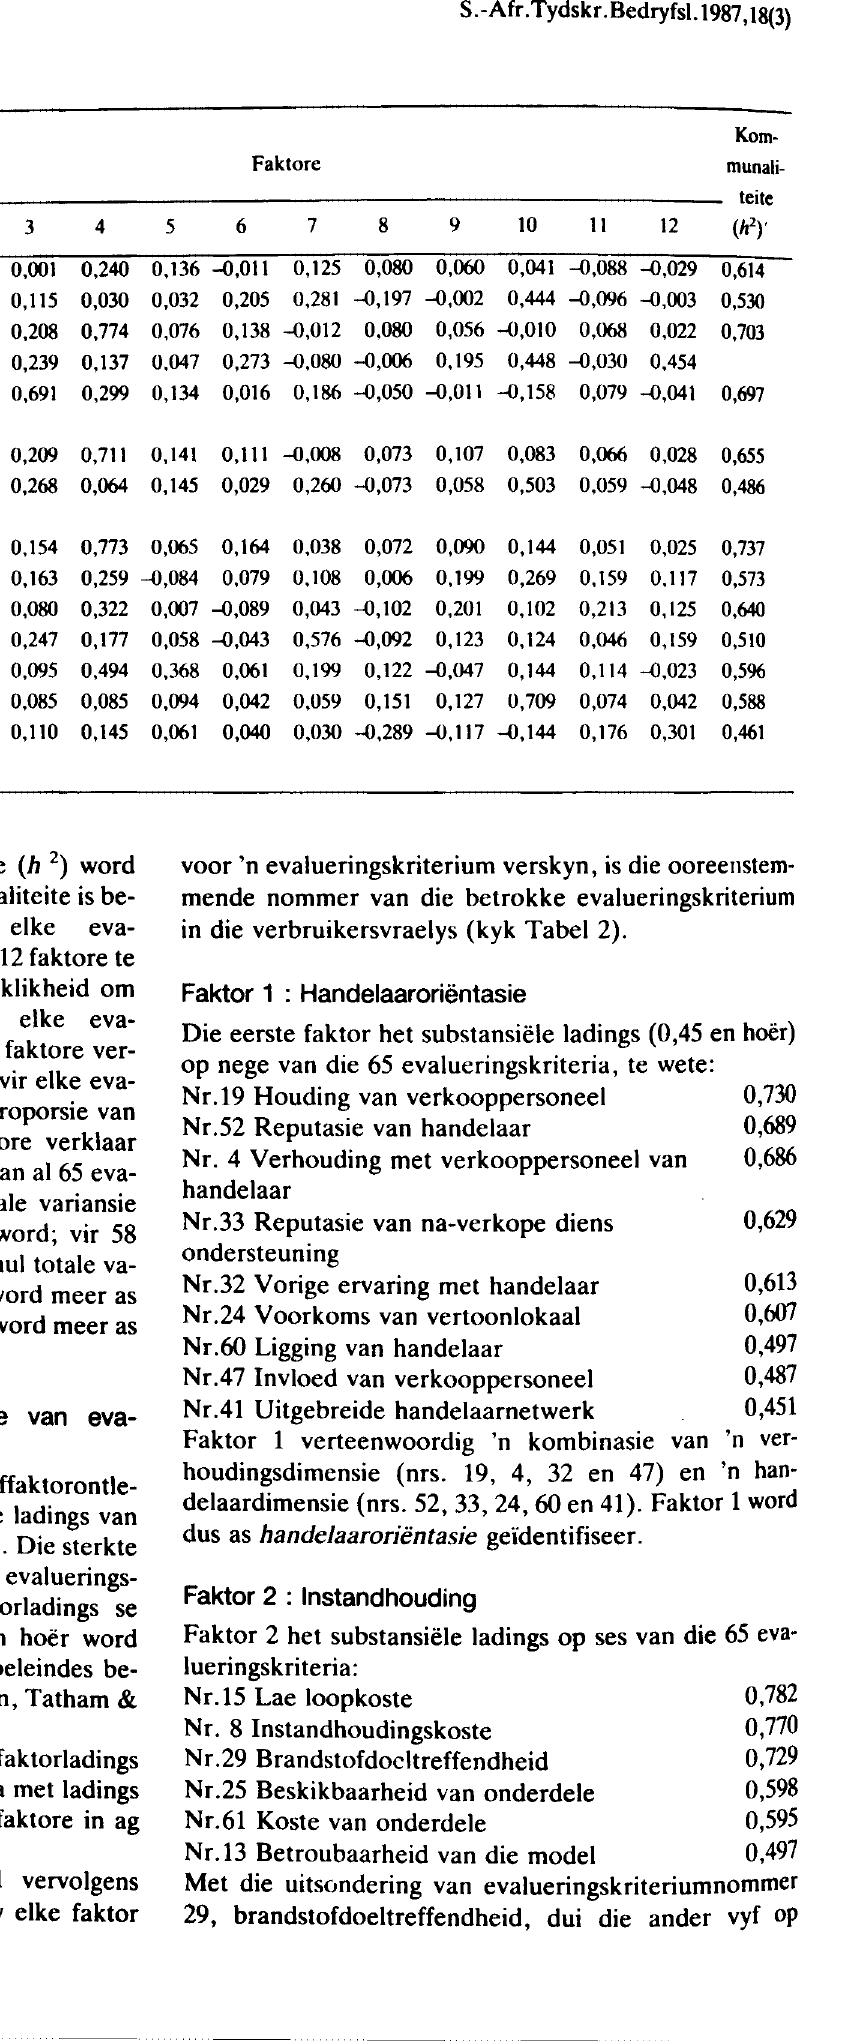
Tabel 5 Vervolg